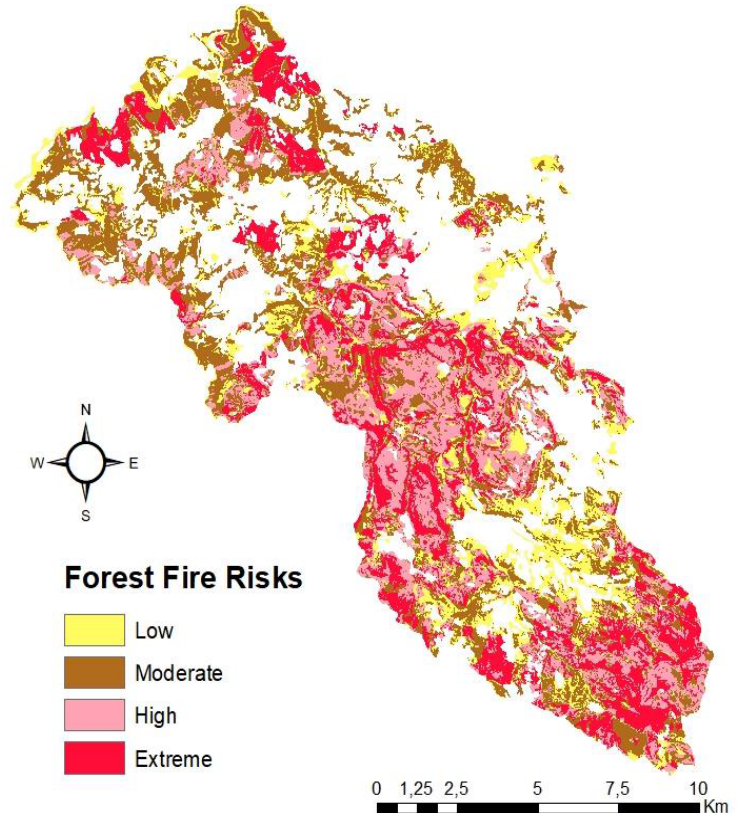
Figure 4 . Forest fire risk